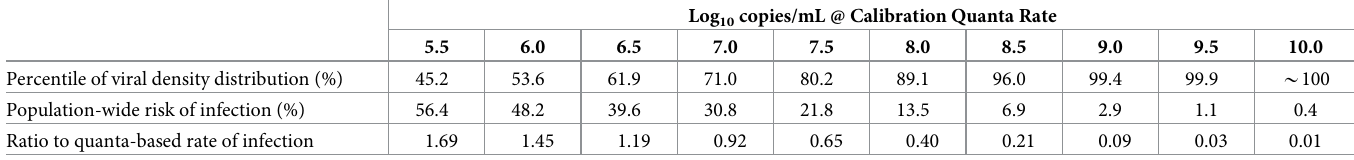
Table 3. Population wide-risks of infection assuming quanta-based risk of 1/3, for different values of the viral density corresponding to the calibration quanta rate. The risk of infection is assumed to be 1/3 at a given viral density (copies/mL) and then averaged across the distribution of viral densities measured by Kleiboeker et al . to derive the population-wide risk of